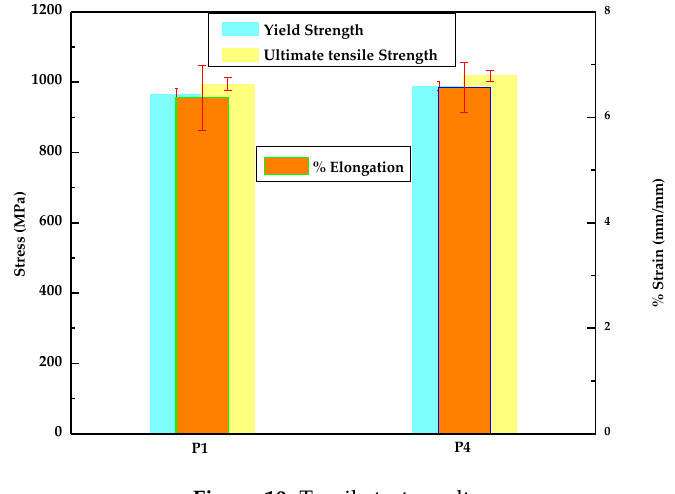
Figure 10. Tensile test results. Table 3. Average tensile test values. Yield strength (YS); Ultimate tensile strength (UTS); percent elongation (% Elong.) and standard deviation (St. Dev.).